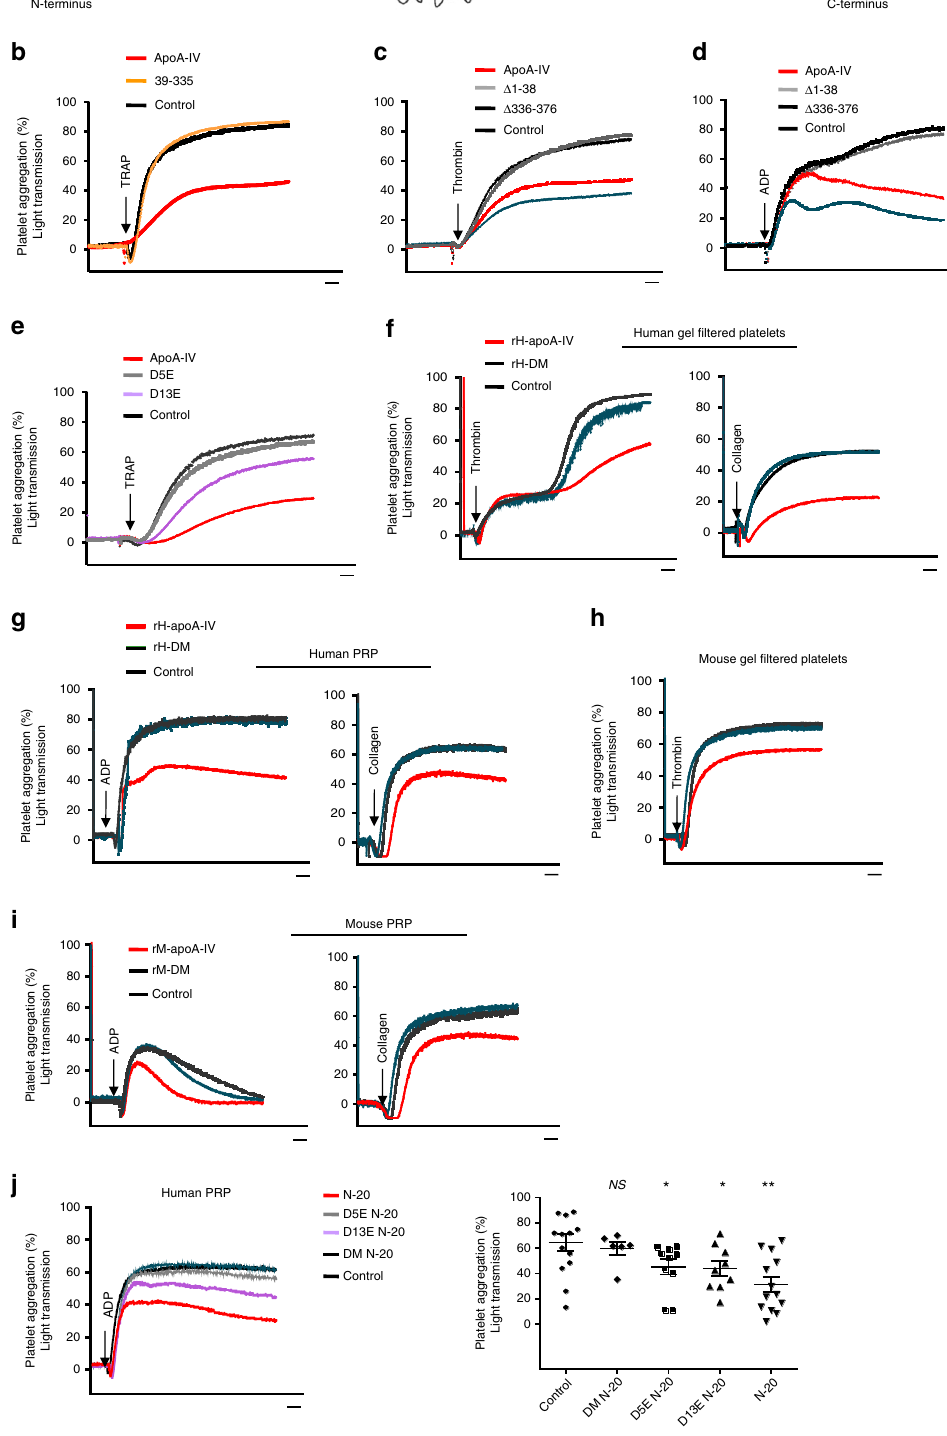
generated recombinant human and mouse double D mutant (DM) apoA-IV with mutations at both of these residues and found that DM apoA-IV abrogated these inhibitory effects (Fig. 4f, i). Consistently, BFP adhesion frequency assay showed that DM apoA-IV did not signi fi cantly bind to α IIb β 3 (Supplementary Fig. 8), resulting in the loss of inhibitory function of apoA-IV (Fig. 4f, i).